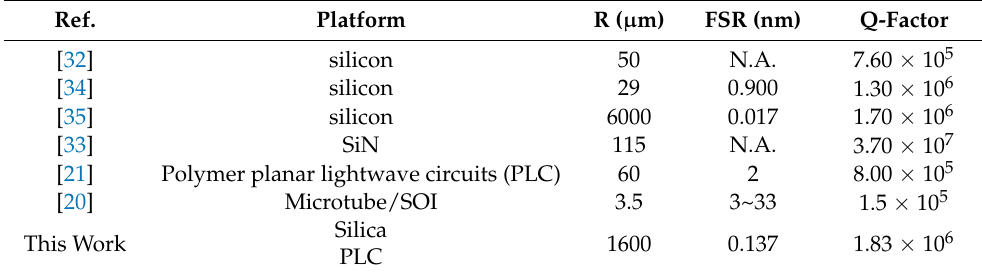
Table 1. Comparison of Ultrahigh-Q Microring Resonators.